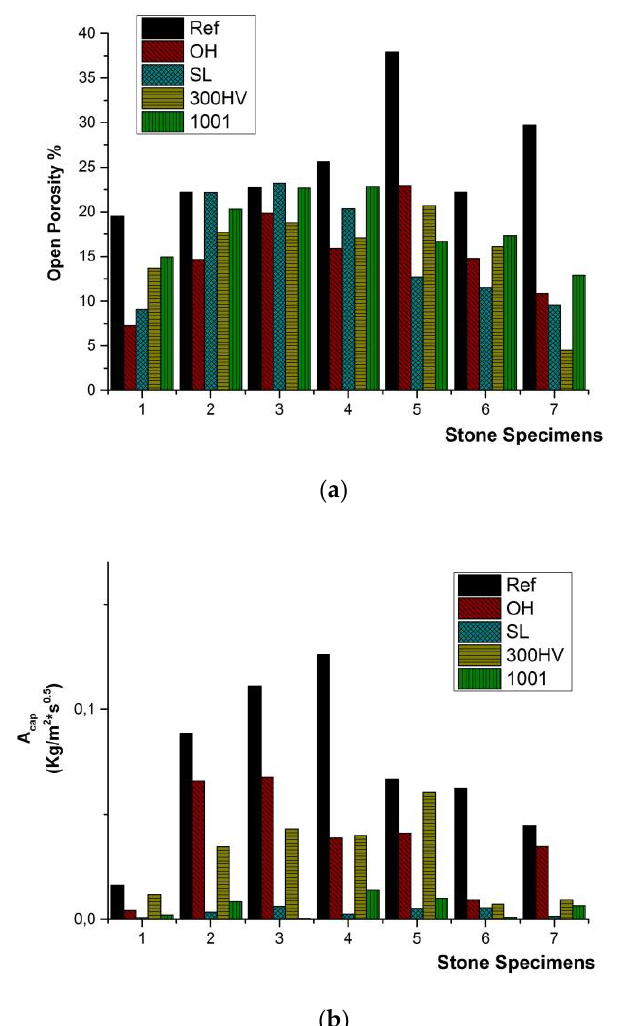
Figure 8. Schematic representation of the effect of the conservation treatments on: ( a ) the open porosity and ( b ) capillary water absorption coefficient (Acap).